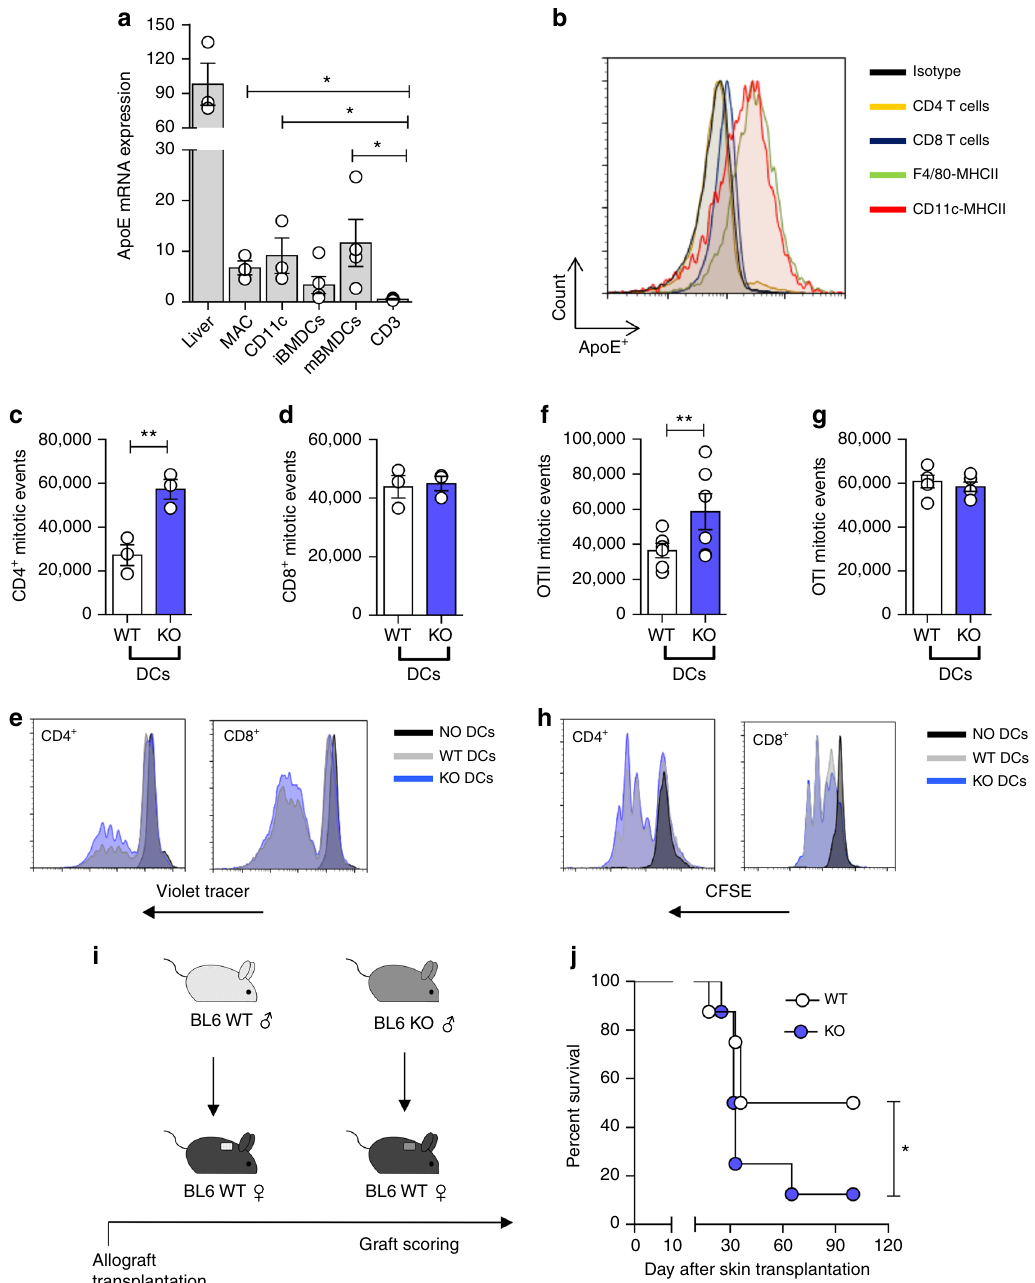
Fig. 3 ApoE regulates DC activation. a mRNA expression relative to RPL (L Ribosomal Protein) of apoE in the liver, resident peritoneal macrophages (MAC), spleen-derived DCs (CD11c + ), bone marrow derived DCs (immature iBMDCs and mature mBMDCs) and T cells (CD3 + ) of WT animals. b representative histogram showing apoE protein determination through fl ow cytometry in T cells (CD4 + and CD8 + ), macrophages (F4/80 + MHCII + ) and DCs (CD11c + MHCII + ) of WT mice. c – e Proliferation of allogenic BALB/c CD4 + ( c ) and CD8 + ( d ) T cells with spleen-derived DCs from WT and apoE KO C57BL/6 mice; representative histograms are presented in e . f – h Proliferation of transgenic OTII CD4 + ( f ) and OTI CD8 + ( g ) T cells with BMDCs isolated from WT and apoE KO mice and pulsed with OTII or OTI peptide; representative histograms are presented in h . i Graphic representation of skin allograft transplantation: a piece of tail skin from a C57BL/6 male donor either WT or apoE KO was transplanted on the back of WT female mice; graft survival was scored up to 100 days. j Percentage of graft survival following skin transplantation. Graft survival of <50% of the donor skin was recorded as rejection. N = 3 (in triplicates c – d ), N = 4 ( a ), N = 6 ( f – g ), N = 8 ( j ) per group. Statistical analysis was performed with unpaired T -test ( a , c , d , f , g ), Gehan-Breslow-Wilcoxon test ( j ). Data are reported as mean ± SEM; * p < 0.05, ** p <